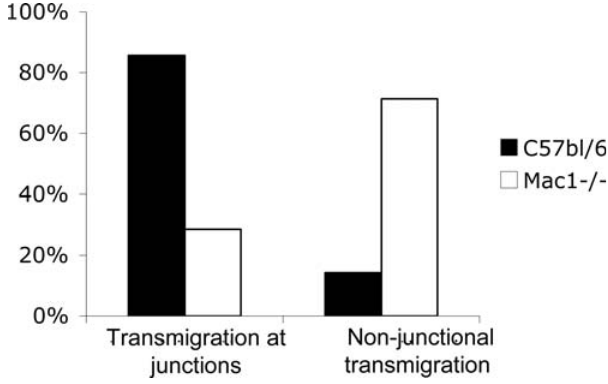
Figure 5. Transmigration in respect to endothelial junctions. The distribution of transmigrating wild-type (n=40) and Mac-1-/- neutrophils (n=24) in respect to junctions on electron micrographs.